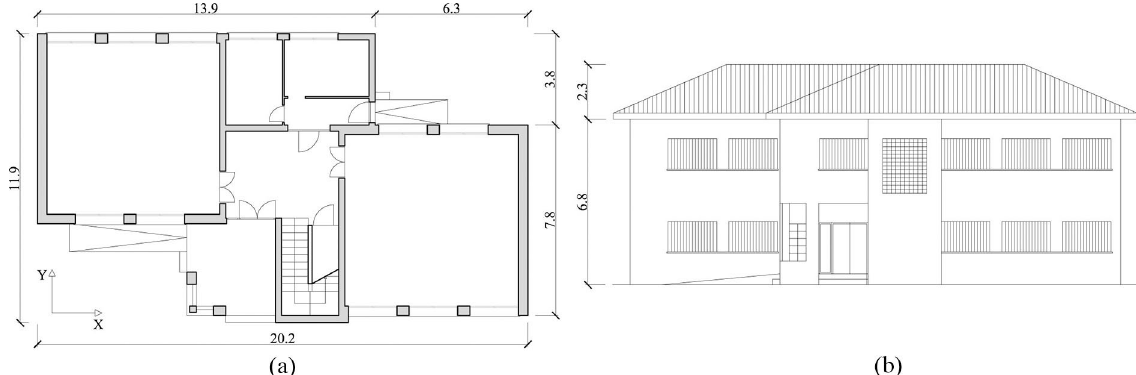
Fig 2. Distribution of the ground floor (a) and main fac¸ade (b) of the case study